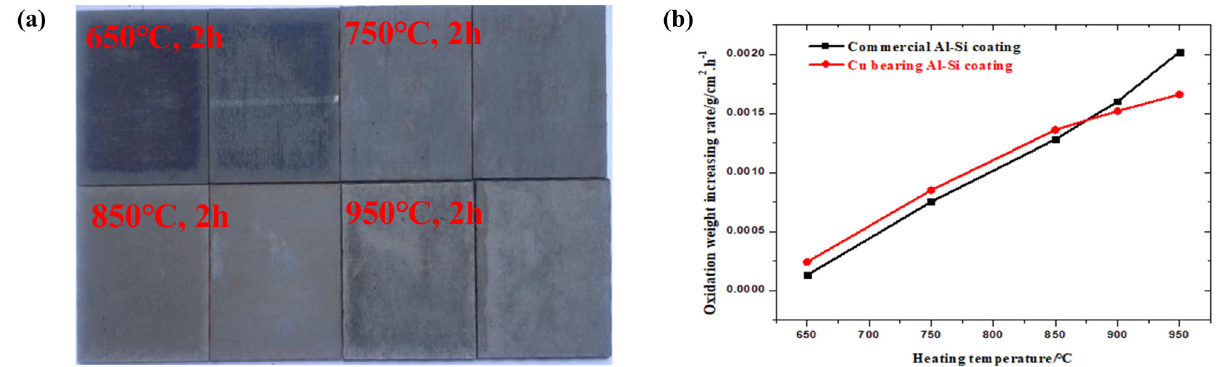
Figure 6: Surface morphology and oxidation weight increasing rate curve of Al – Si – Cu coating after heating with di ff erent temperatures: ( a ) Al – Si – Cu coating surface morphology and ( b ) oxidation weight increasing rate